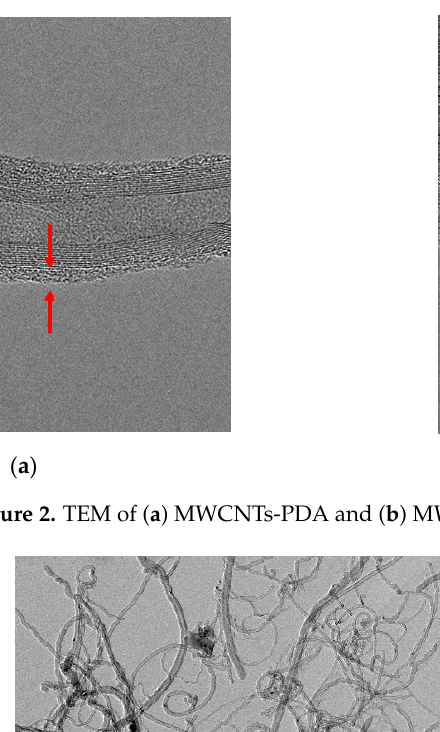
Figure 4. UV-Vis spectra of MWCNT-PDA-PDMAEMA in water, inset ( a ) before CO 2 purge and ( b ) after CO 2 purge.